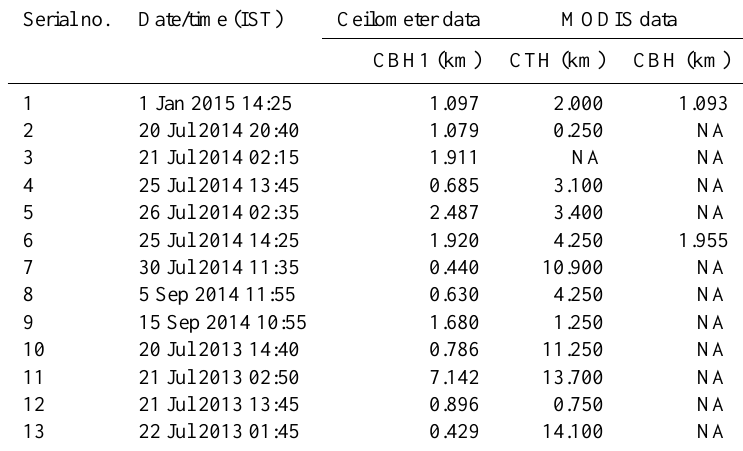
Table 2. Comparison between ceilometer and MODIS satellite-measured clouds. Serial no.